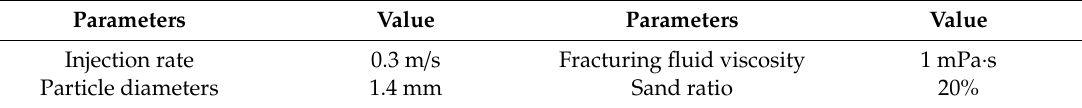
Table 7. Necessary parameters in the